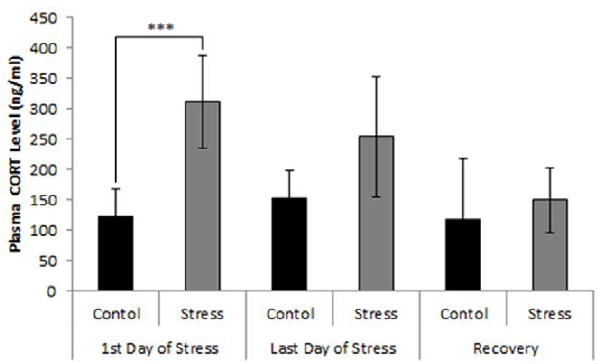
Figure 2. Concentration of plasma corticosterone (means ± SD; ng/ml) in control and stress animals as measured on the first day of stress, last day of stress and after two weeks of recovery from stress (‘‘Recovery’’). Asterisks represent statistical significance (*** p ,